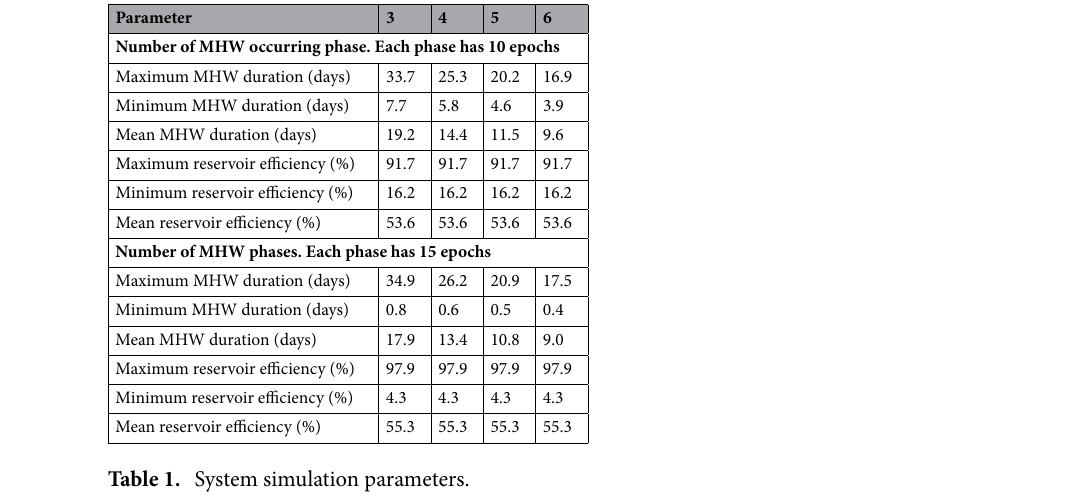
Table 1. System simulation